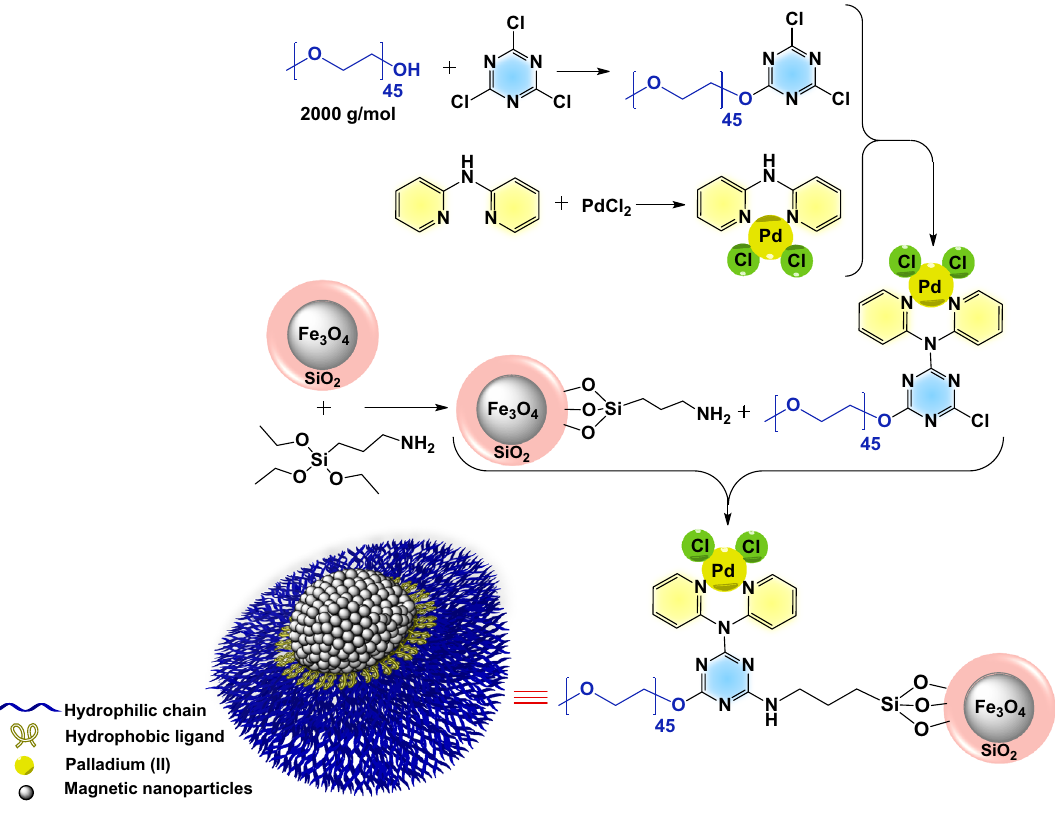
Figure 1. Schematic procedure for the preparation of MNPs@SiO 2 -NH 2 @Pd(dpa)Cl 2